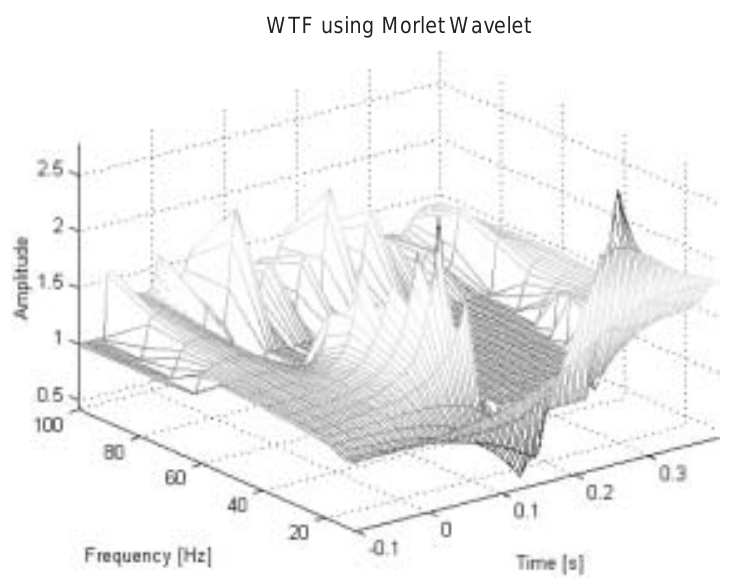
Fig. 10. WTF no clipping of the transient response of the damaged beam using sensors S1 and S2.